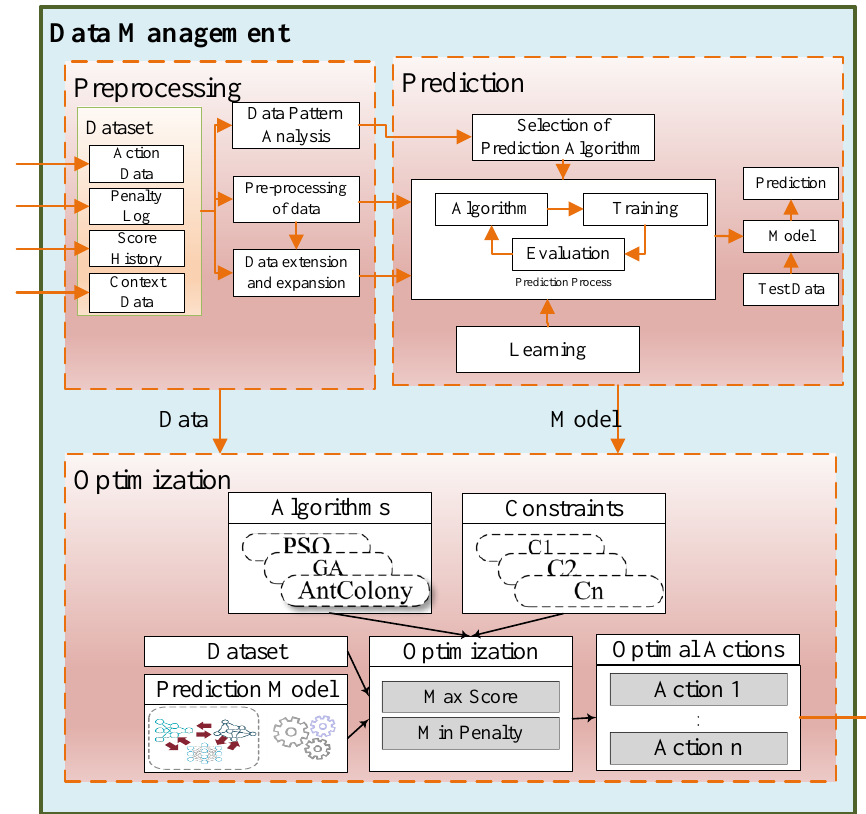
Figure 3. Block representation of the data management component.